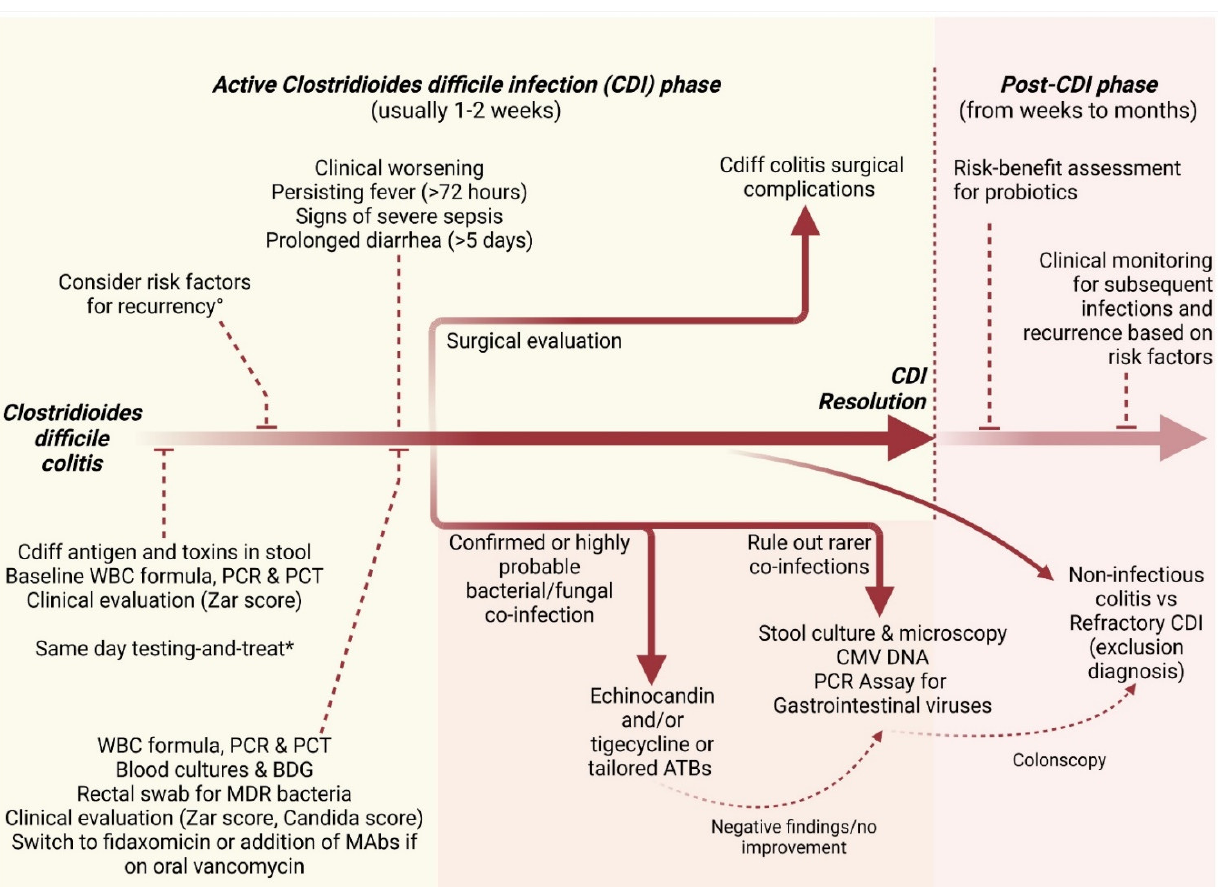
Figure 3. Practical flow-chart on Clostridioides difficile and co-infections clinical management. Legend: WBC, white blood cells; PCR, C reactive protein; PCT, procalcitonin; BDG, beta-D-glucan; MDR, multi-drug resistant; MAbs, anti-toxin B monoclonal antibodies (bezlotoxumab). * If possible prefer “microbiota-preserving” treatments, such as fidaxomicin.